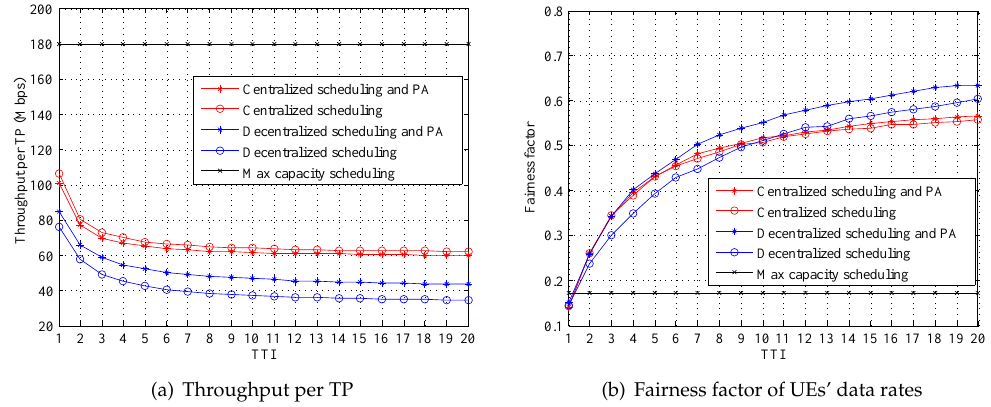
Figure 4. System performances under different resource allocation algorithms (20 Watts, infinite C m , R thres = 180 kbps).